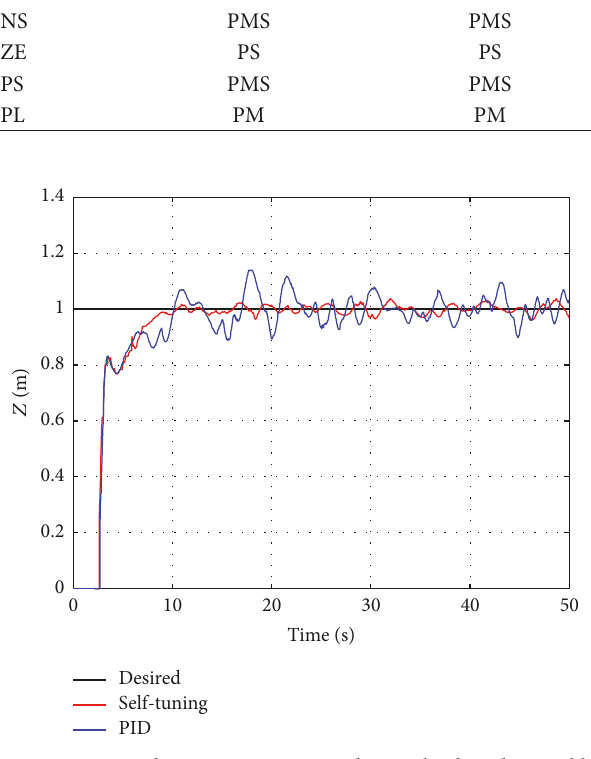
Figure 19: Quadrotor 𝑧 position under payload with variable weight.